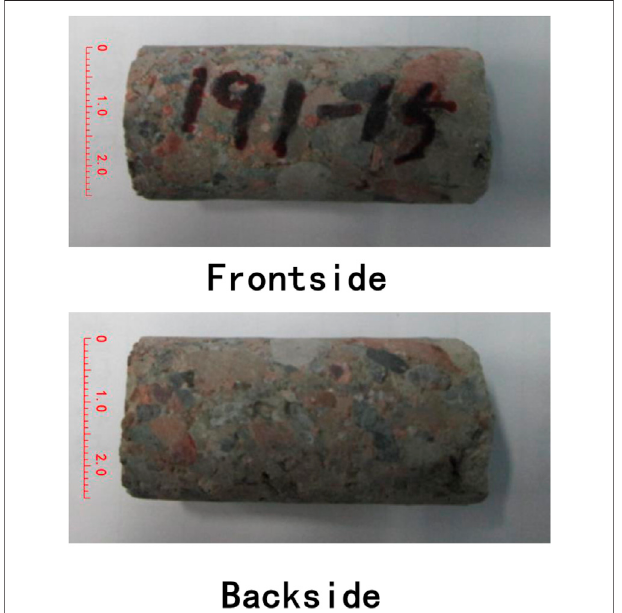
FIGURE 1 | Conglomerate rock sample used for the compression test.